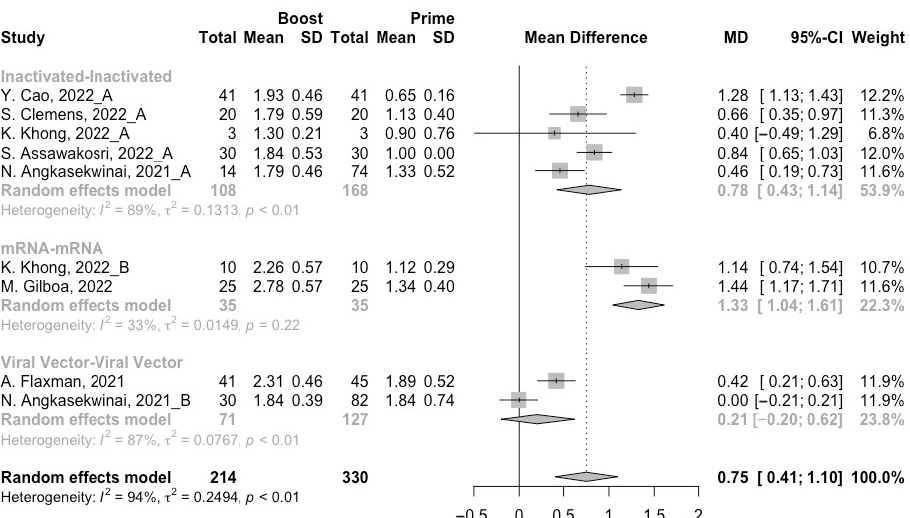
Figure 6. Forest plot of the pooled log-transformed neutralization titers against the Beta variant be- fore and after homologous booster vaccination.